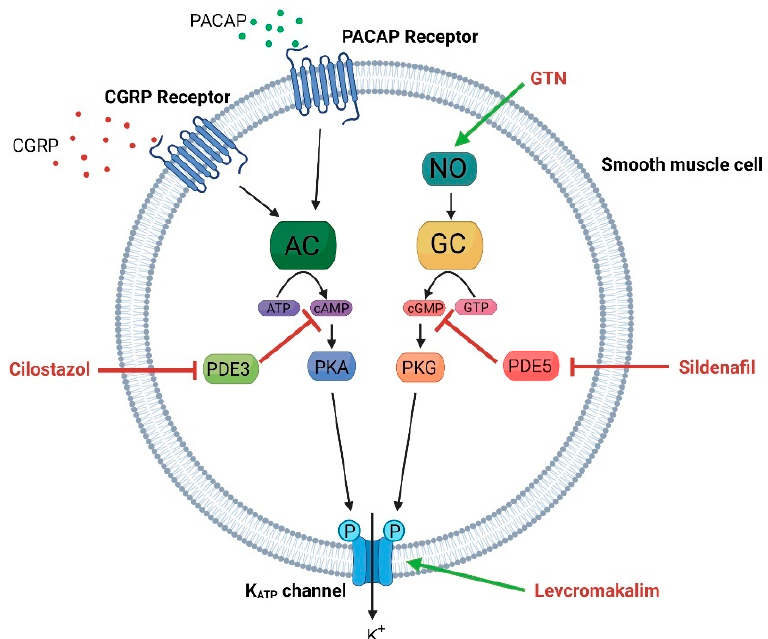
Figure 2. Molecular pathways and pharmacological agents leading to the opening of the K ATP chan- nel in vascular smooth muscle. The neuropeptides PACAP and CGRP activate K ATP channels via the adenylyl cyclase pathway, while the NO donor GTN (glyceryl trinitrate) activates the channel via the guanylyl cyclase pathway. Cilostazol and Sildenafil are blockers of the phosphodiesterase 3 and 5 (PDE3 and PDE5), respectively, causing accumulation of cAMP and cGMP, which promote the opening of K ATP channels. Levcromakalim causes vasodilation by direct action on the K ATP channels (created using BioRender.com).